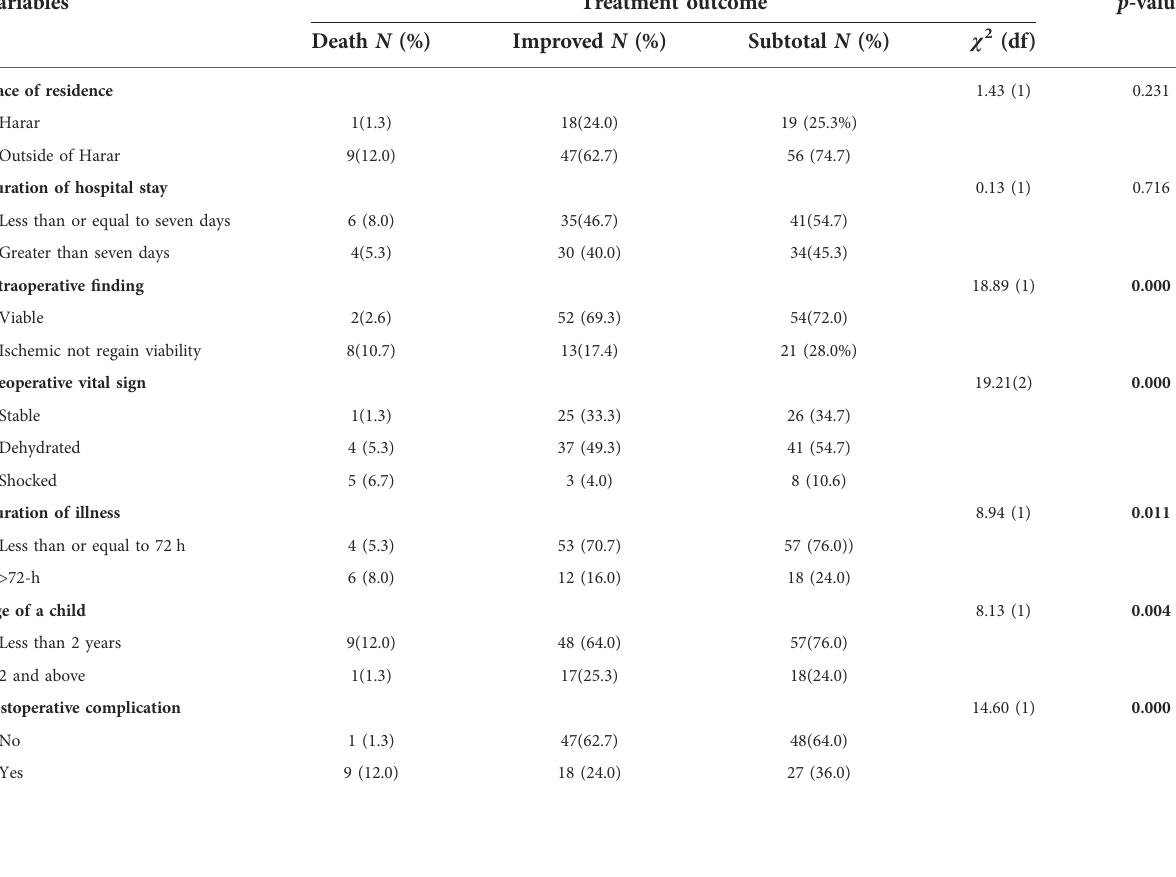
TABLE 3 Factors associated with treatment outcome among children admitted and managed for acute intussusception at HFSUH, Eastern Ethiopia, 2021 ( n =75). Variables Treatment outcome p -value Death N